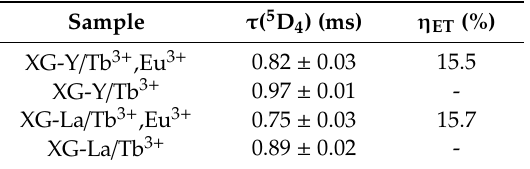
Table 1. Luminescence lifetimes of the 5 D 4 state of Tb 3 + ( τ ) and ET e ffi ciencies ( η ET ) for fabricated silicate